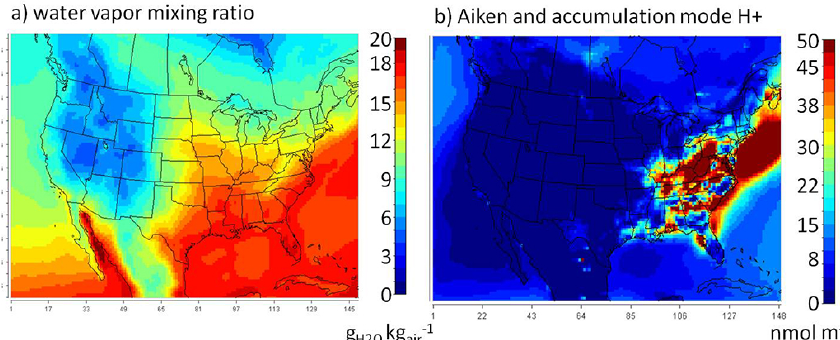
Fig. 5. Water vapor mixing ratio (a) and aerosol-free acidity (b) at the surface averaged for July